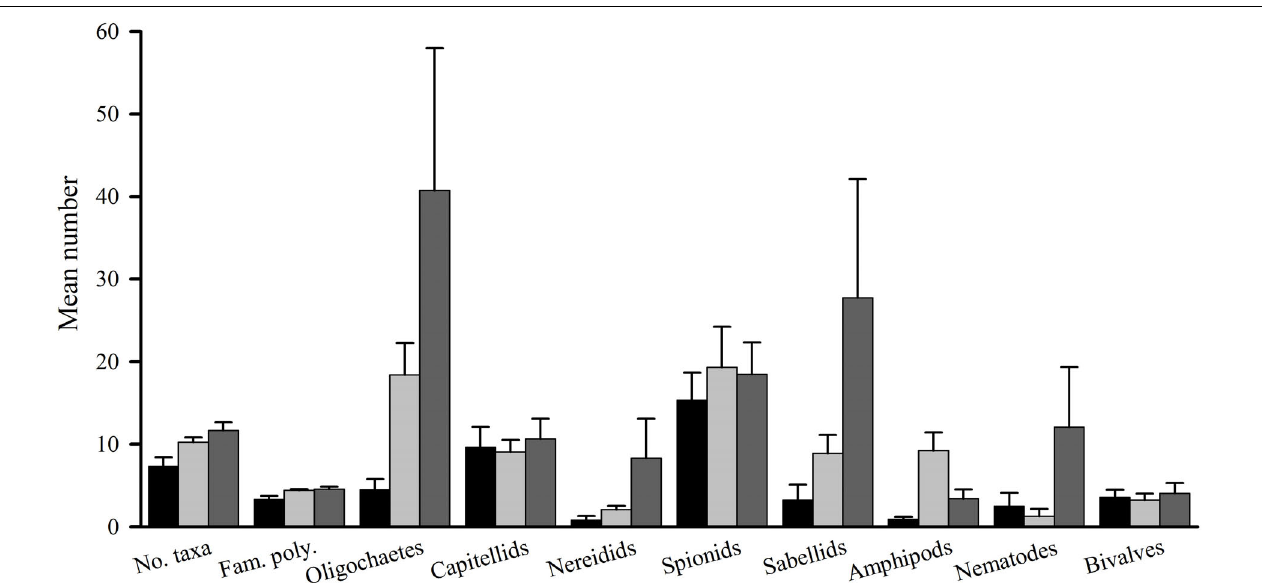
FIGURE 7 | Tambourine Bay macrofauna after 3 months. Mean ( SE ; n = 6 plots) number of taxa, families of polychaetes and abundance of oligochaetes, capitellids, nereidids, spionids, sabellids, amphipods, nematodes, and bivalves in heavily shaded plots with black roofs (black bars), lightly shaded plots with clear roofs (dark gray bars), and unshaded control plots (light gray